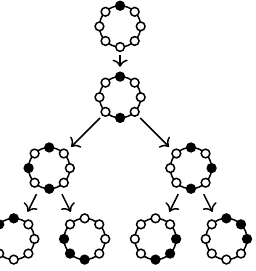
Figure 2. The “strategy tree” in the Scotland Yard game for catching a thief on a circle using three detectives. A tree decomposition of the circle is obtained from this strategy tree by replacing the small graphs shown in the nodes by so-called “bags” consisting of the black vertices in each of the small graphs.